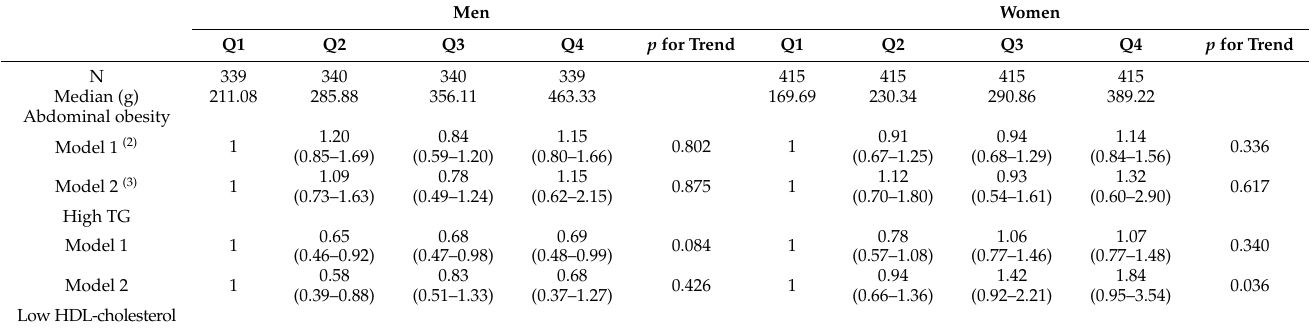
Table 5. OR of metabolic abnormalities according to quartile of carbohydrate consumption (1) .